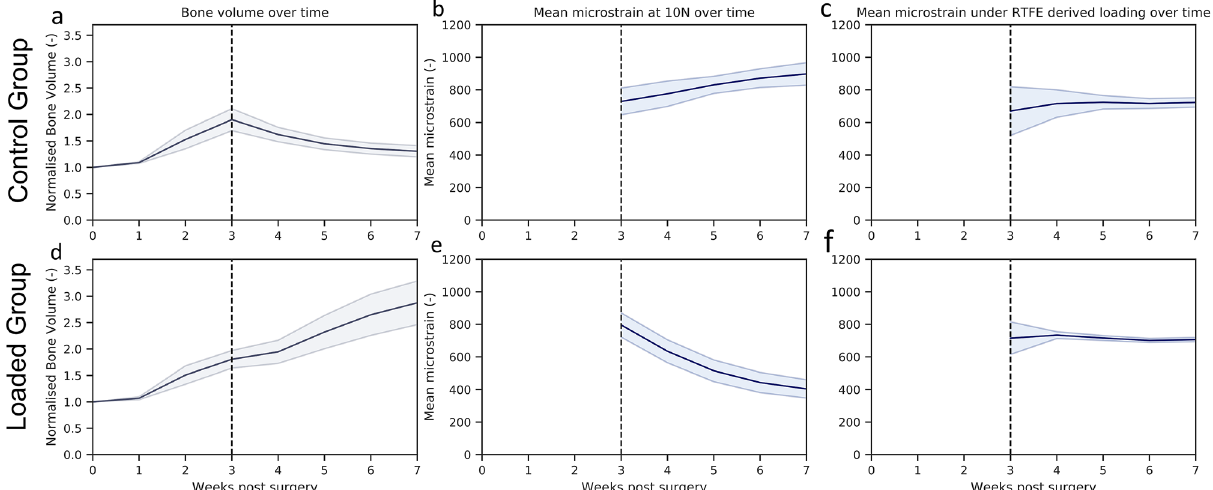
Figure 2. As bone volume decreases ( a ), or increases ( d ), the mechanical strains increase ( b ) or decrease ( e ), respectively throughout the duration of the loading period. This causes a changing mechanical environment at each point of time. ( c , f ) Display the application of the rtFE approach to ensure this change in the local mechanical environment does not occur. Additionally, comparisons between ( b ) and ( c ), and ( e ) and ( f ), show the reduction of variance caused by rtFE specifying appropriate loading parameters on an individualised basis. Bone volume is normalised to the amount of bone volume at week 0 post surgery.